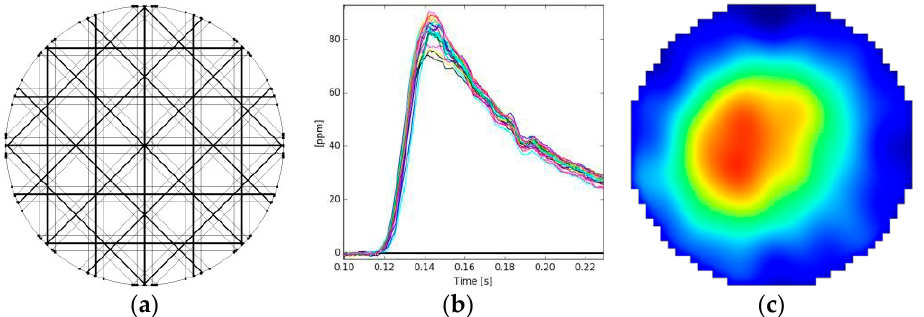
Figure 2. measurement procedure; ( a ) regular beam arrangement of 20 beams through the cross section; ( b ) time signal of one injection pulse measuring 20 line concentrations; ( c ) gas distribution result after reconstructing the line concentrations at a specific